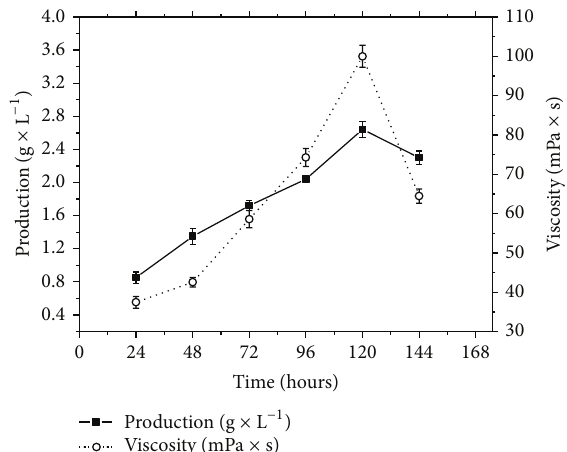
Figure 3: Production and viscosity of xanthan gum obtained at different fermentation times by using strain